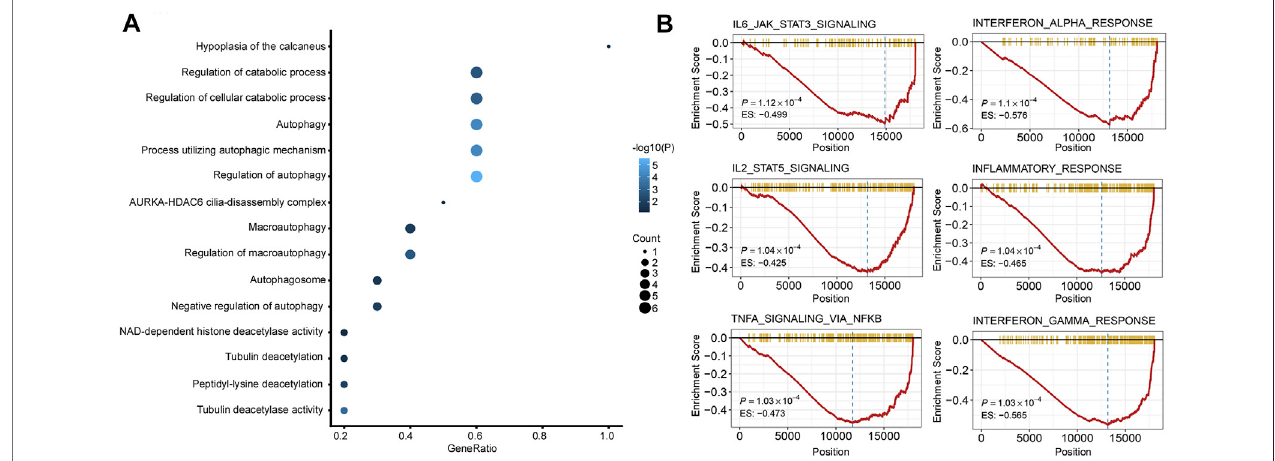
FIGURE 6 | Functional analysis of the 10 autophagy signature genes. (A) . Gene ontology (GO) of the 10 autophagy signature genes. (B) . GSEA showed some immune/in fl ammatory pathways downregulated in high autophagy risk patients.